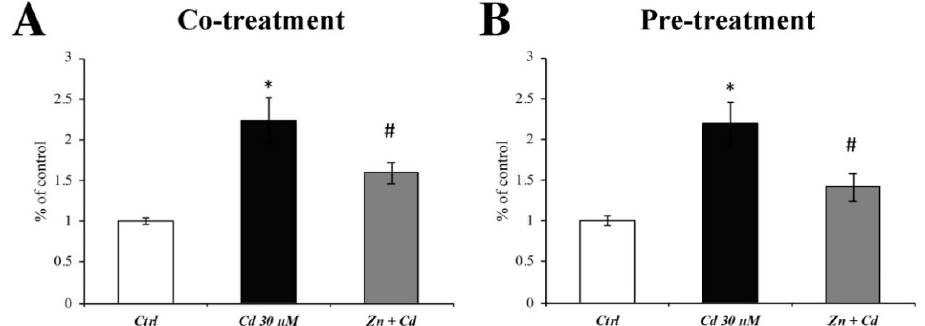
Figure 2. Evaluation of ROS production. The flow cytometry analysis showed a significant increase in ROS production when cells were treated with Cd 30 mM for 8 h. Zn cotreatment ( A ) or 8 h pre- treatment ( B ) was able to significantly counteract the Cd-induced ROS overproduction. Results are expressed as mean ± SEM, and control (Ctrl; untreated cells) was arbitrarily taken as 100%. Each experiment point was performed in triplicate, from three different sets of experiments. * p < 0.05 vs. Ctrl; # p < 0.05 vs. Cd treatment.